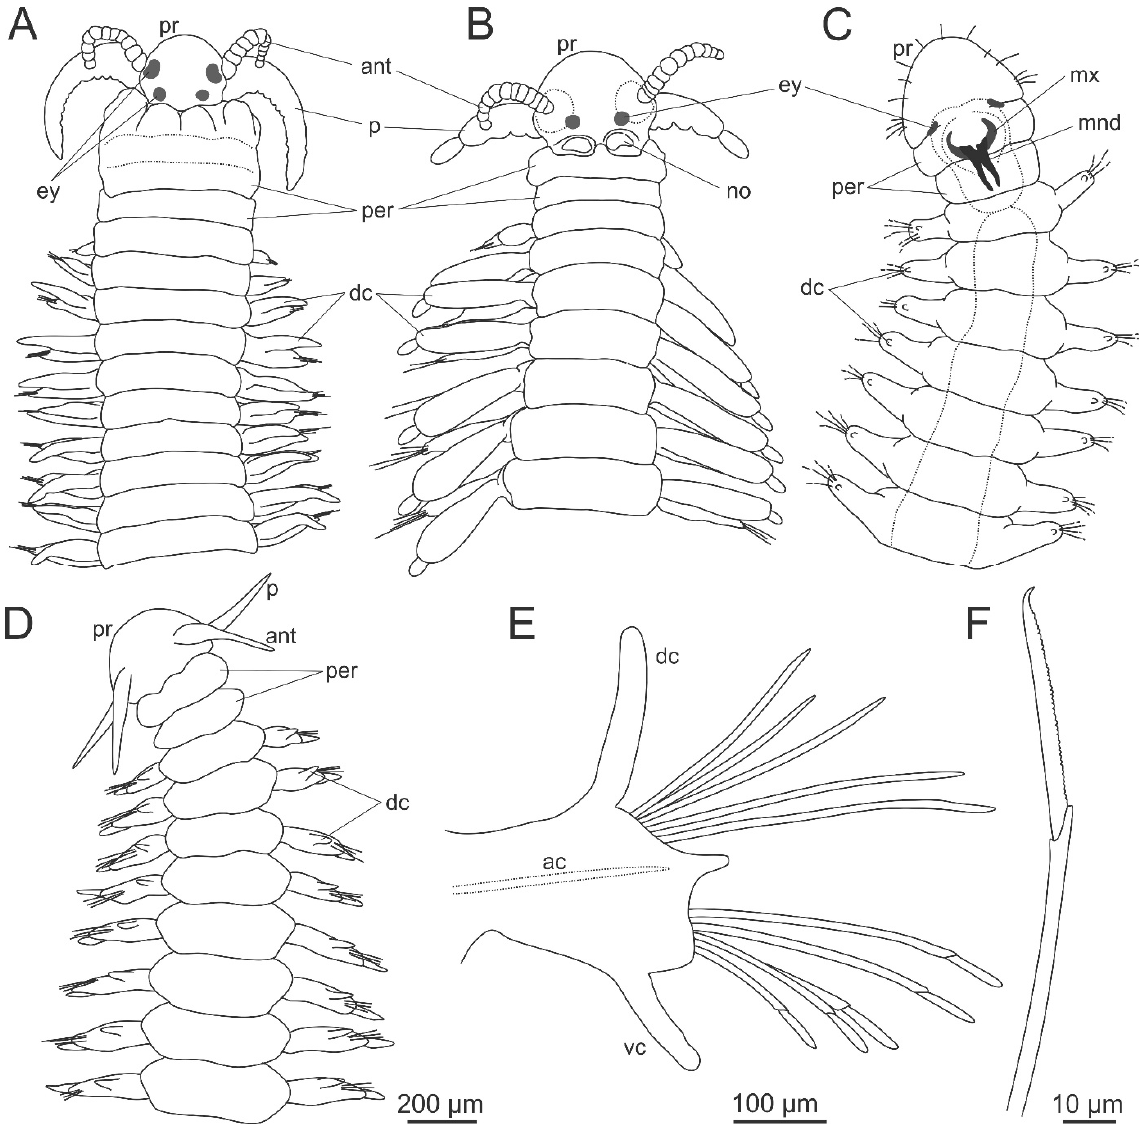
Figure 4. Morphology of Dorvilleidae. ( A ), ( B ) Dorvilleidade gen. sp. anterior end, dorsal view; ( C ) Ophryotrocha sp. Anterior end, dorsal view; ( D ) Ophryotrocha langstrumpae Wiklund, Altamira, Glover, Smith, Baco and Dahlgren, 2012, anterior end, dorsal view; ( E ) the same, midbody parapodium; ( F ) the same, compound chaeta. ac—acicula, ant—antenna, dc—dorsal cirrus, ey—eye, mnd—mandibles, mx—maxillae, no—nuchal organ, p—palp, per—peristomium, pr—prostomium, vc—ventral cirrus. ( D–F ) modified from Wiklund et al. [74].